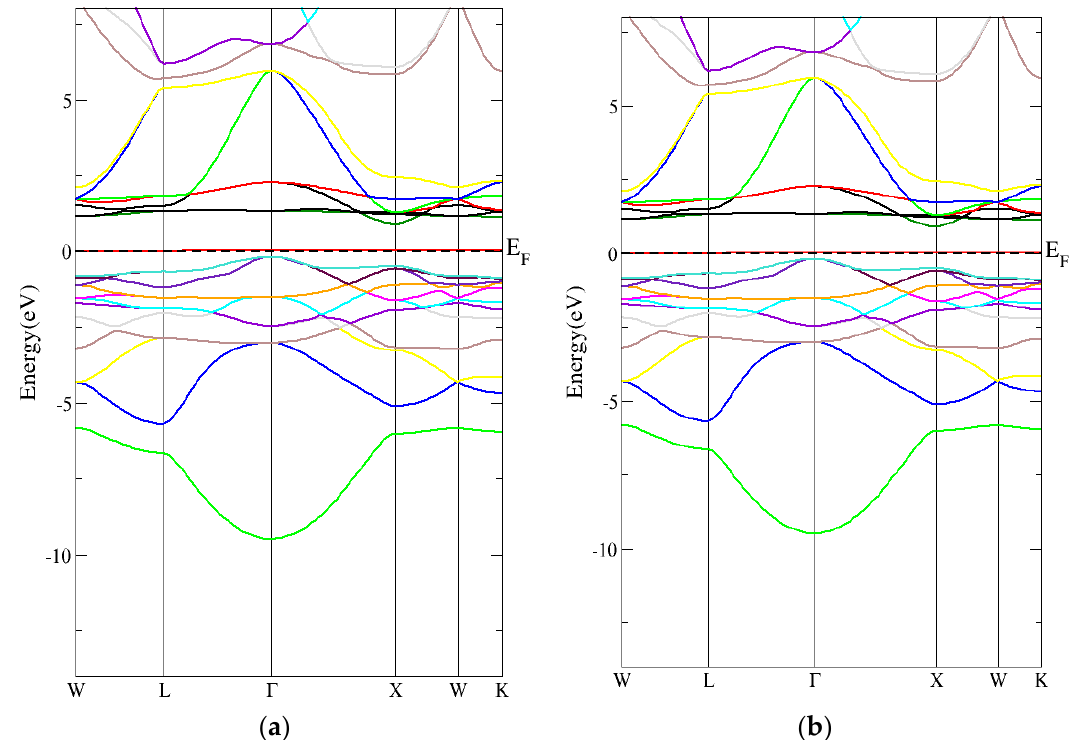
Figure 7. The band structure for the conventional Heusler Co (cid:2870) CrAl compound by employing the mBJ–GGA technique for ( a ) spin-up conventional Heusler Co (cid:2870) CrAl compound and ( b ) spin-down conventional Heusler Co (cid:2870) CrAl compound.